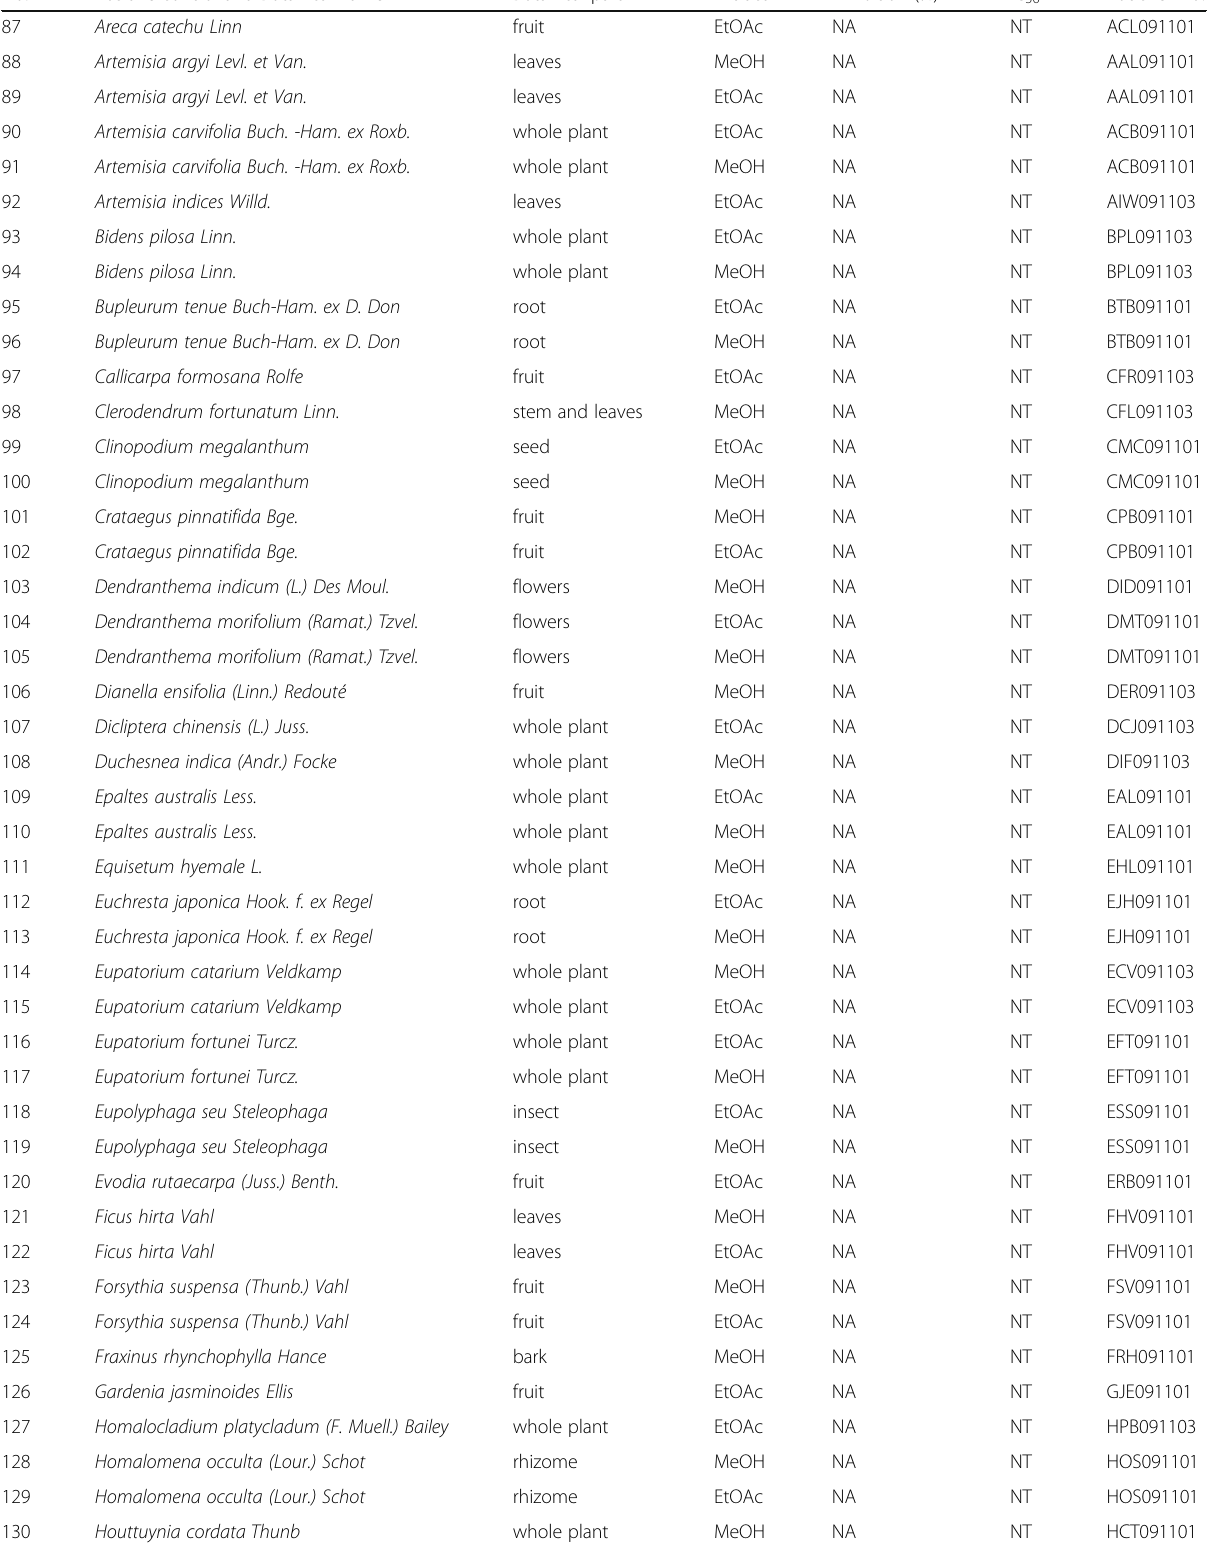
Table 1 Inhibitory activities of Chinese herbs extract on A(H1N1) influenza virus neuraminidase (Continued)